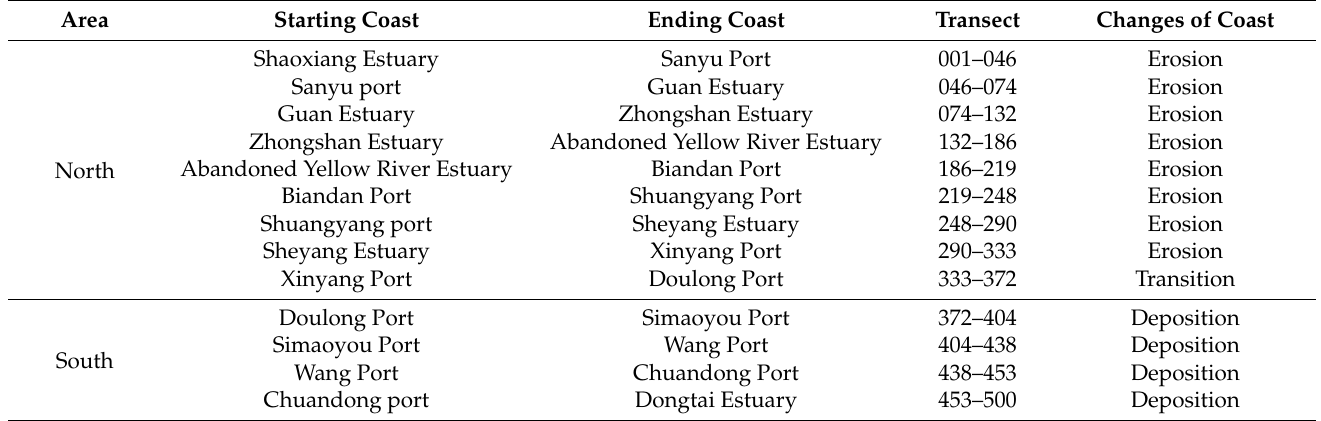
Table 2. Spatial distribution characteristics of each